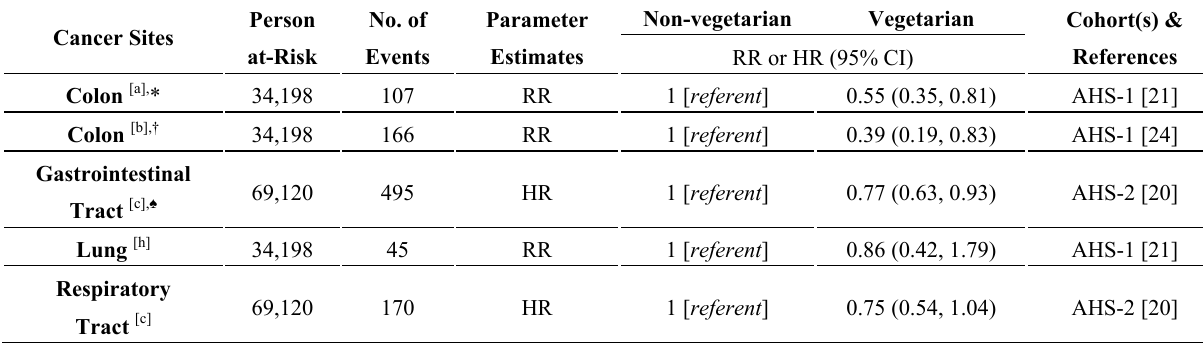
Table 4. All-cancer and cancer-specific sites among vegetarian and non-vegetarian